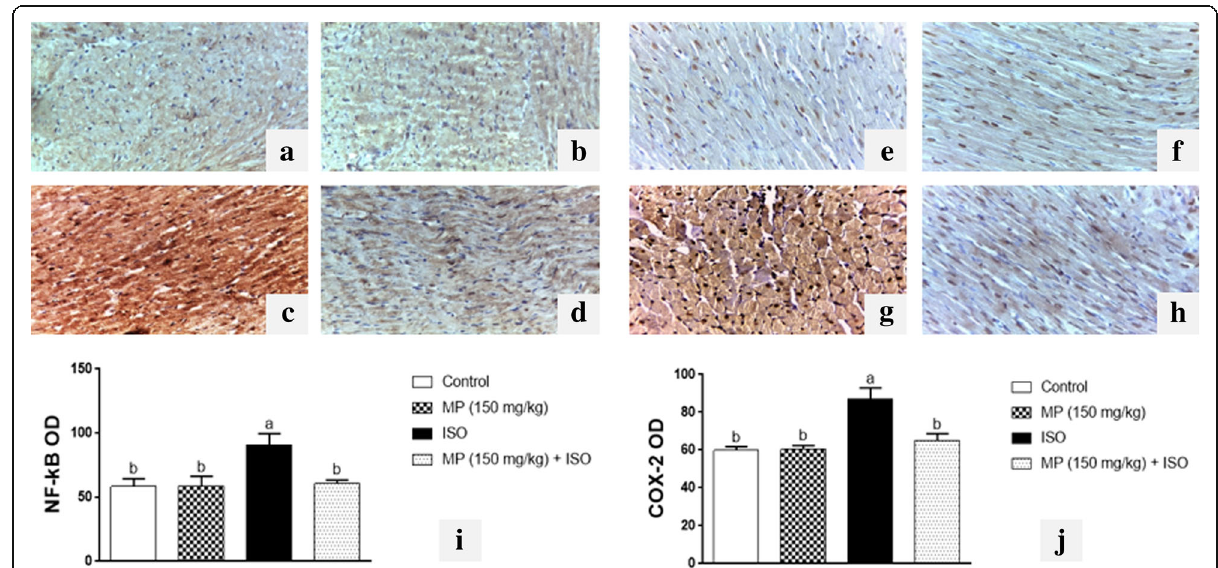
Fig. 8 Immunohistochemical analysis of NF-kB and COX-2 in heart sections (magnification × 400). a and e Control group showing normal architecture with minimal expression of NF-kB and COX-2 respectively. b and f MP group showing minimal expression of NF-kB and COX-2 respectively. c and g ISO-intoxicated group showing extensive heavy expression of NF-kB and COX-2 respectively. d and h MP-pretreated group showing mild expression of NF-kB and COX-2 respectively. i and j Quantitative image analysis for immunohistochemical staining of NF-kB and COX-2 respectively expressed as optical densities (OD) across 10 different fields for each rat section. Data are presented as mean ± SD ( n = 10); a or b: significantly different from control or ISO groups respectively at P < 0.05 using one-way ANOVA followed by Tukey as post hoc test. MP methyl palmitate, ISO isoproterenol, NF-kB nuclear factor kappa B, COX-2 cyclooxygenase